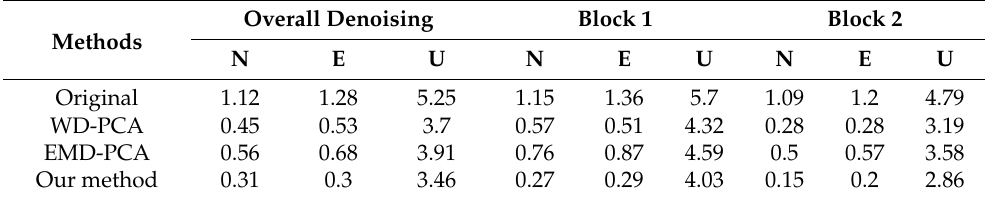
Table 3. Average standard deviations of raw and denoised residual data